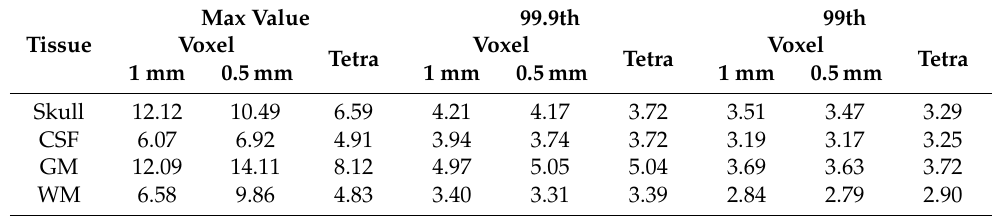
Table 5. Deviation of the E -field in the homogeneous case—all values are expressed in mV/m.